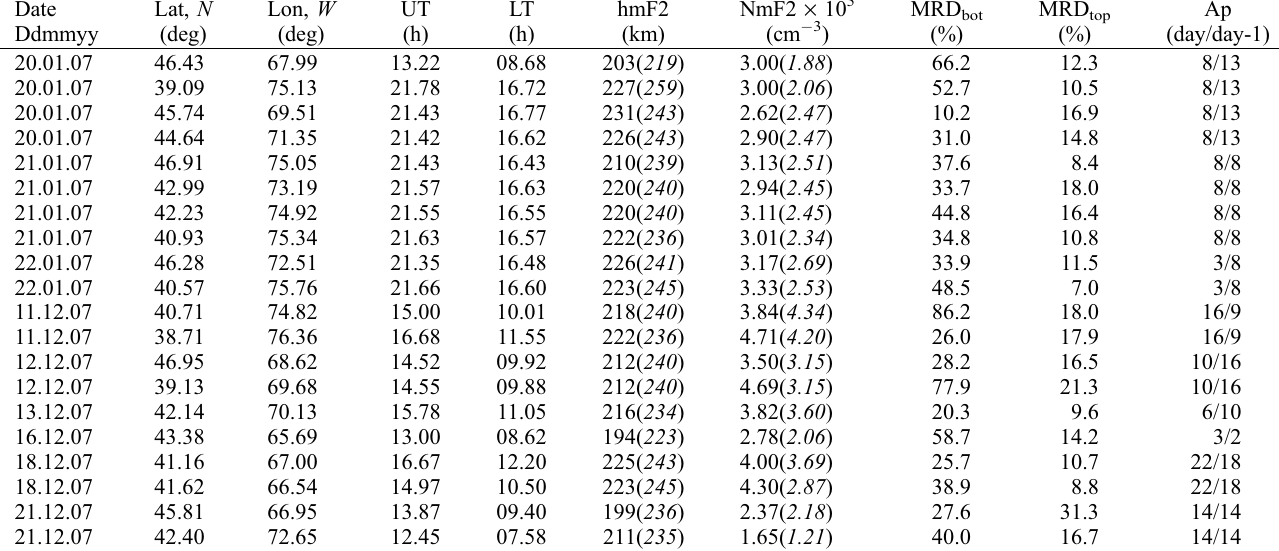
Table 2. Dates of simultaneous Millstone Hill ISR/COSMIC IRO observations for winter months. The coordinates of tangent points, UT and LT of measurements as well as the observed hmF2 and NmF2 values (italic – ISR values) are given. Mean relative deviations are shown when the topside and bottom side of Ne(h) are compared. Daily Ap indices for the current and previous days are given.